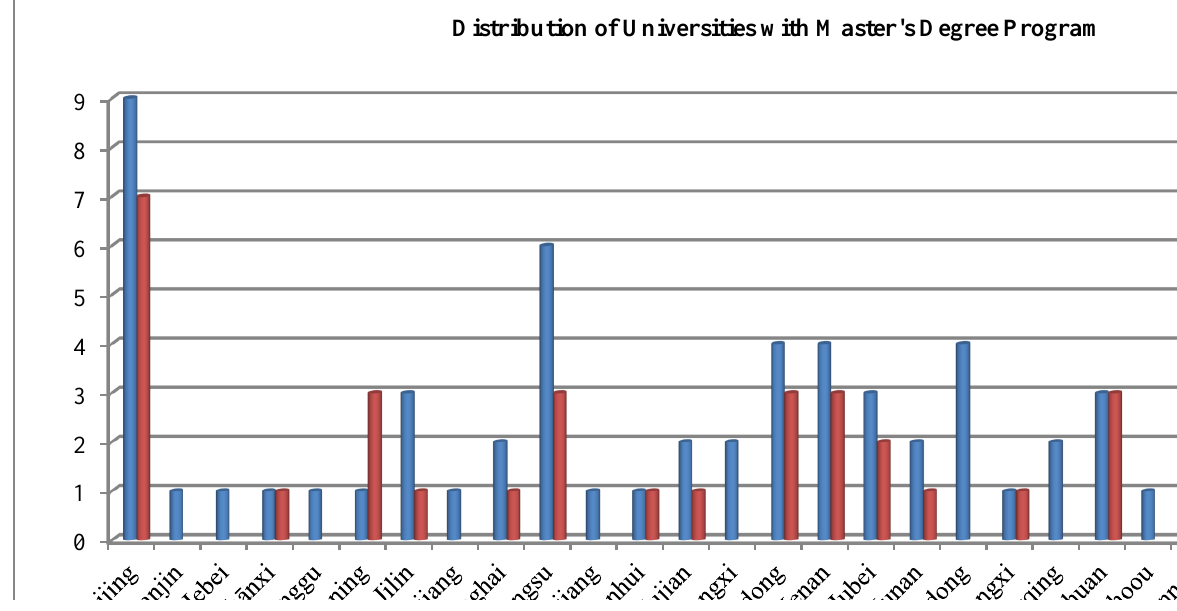
Figure 2. Distribution of Universities with Master's Degree